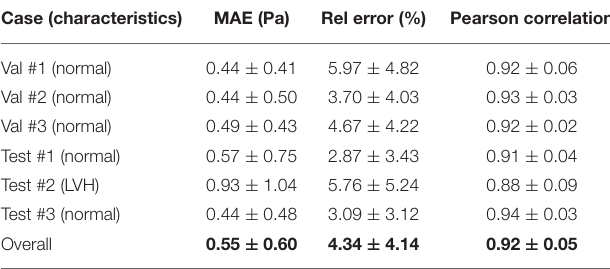
TABLE 1 | Wall shear stress (WSS) magnitude and pattern similarity measurements for the validation and test cases from the CFD simulations. Case